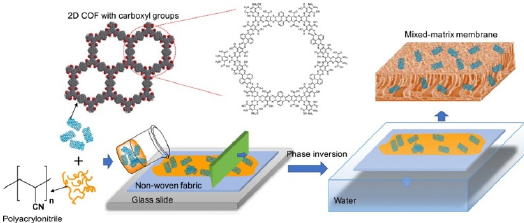
Figure 12. Schematic illustration for the fabrication of mixed-matrix ultrafiltration membrane, molecular structures of the polymer matrix (polyacrylonitrile) and the 2D nanofiller (COF). Reprinted with permission from [99], Copyright (2019) Elsevier.